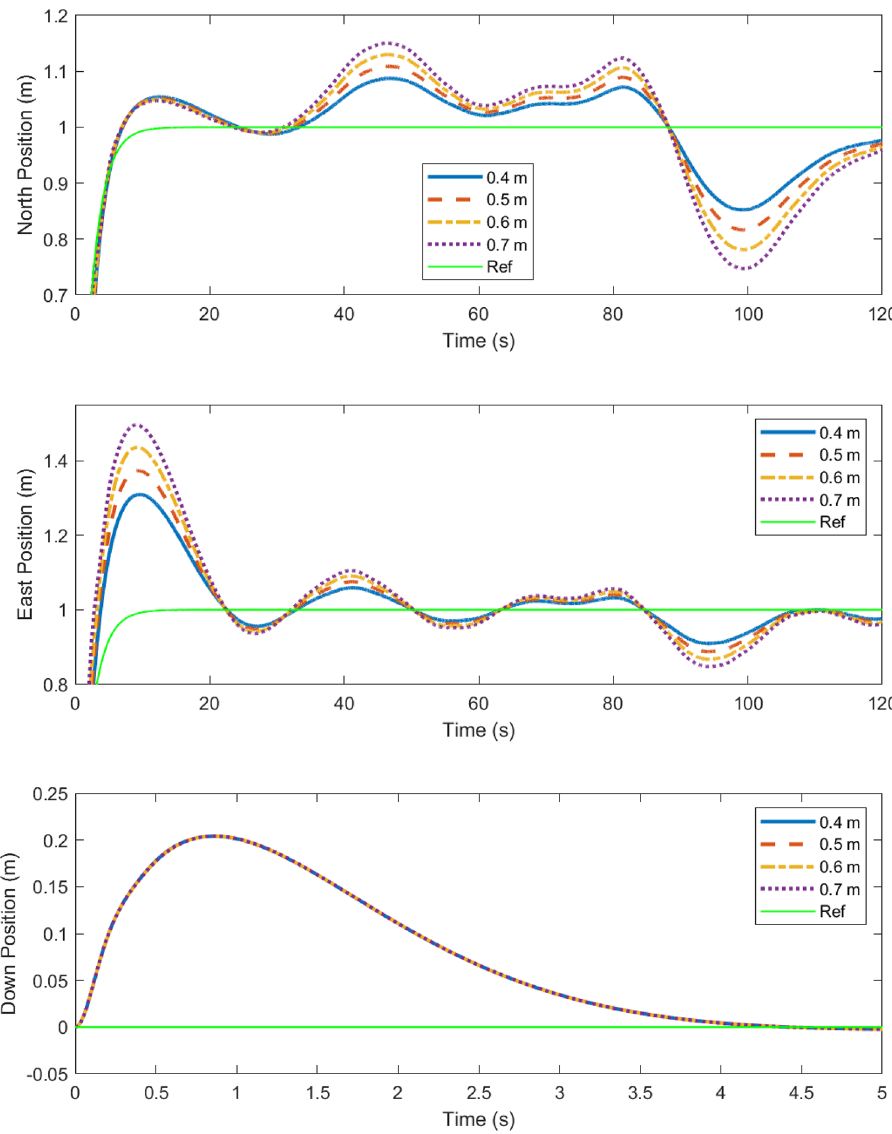
Figure 8. The N, E and D trajectories from Fig. 7 are shown here in greater detail, demonstrating robustness in responses in spite of turbulence due to wind 32